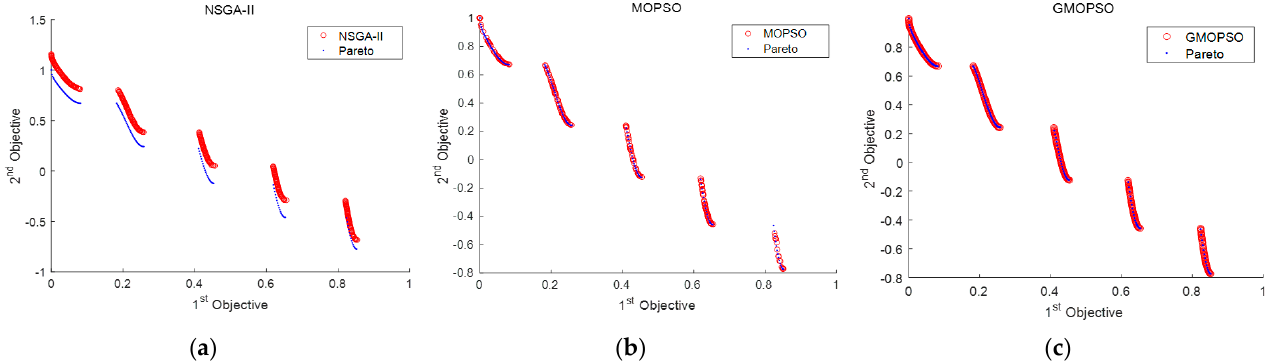
Figure 6. Test results of function ZDT3. ( a ) Pareto solutions of NSGA-II; ( b ) Pareto solutions of MOPSO; ( c ) Pareto solutions of GMOPSO.